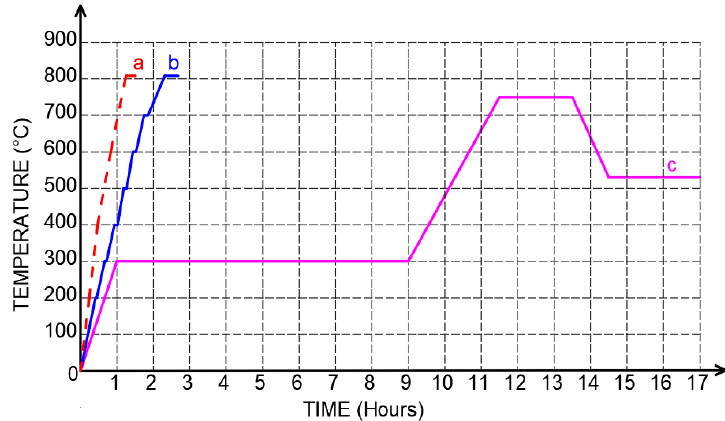
Figure 4. (a) Fast, (b) slow, and (c) multi – step heating rate chart.